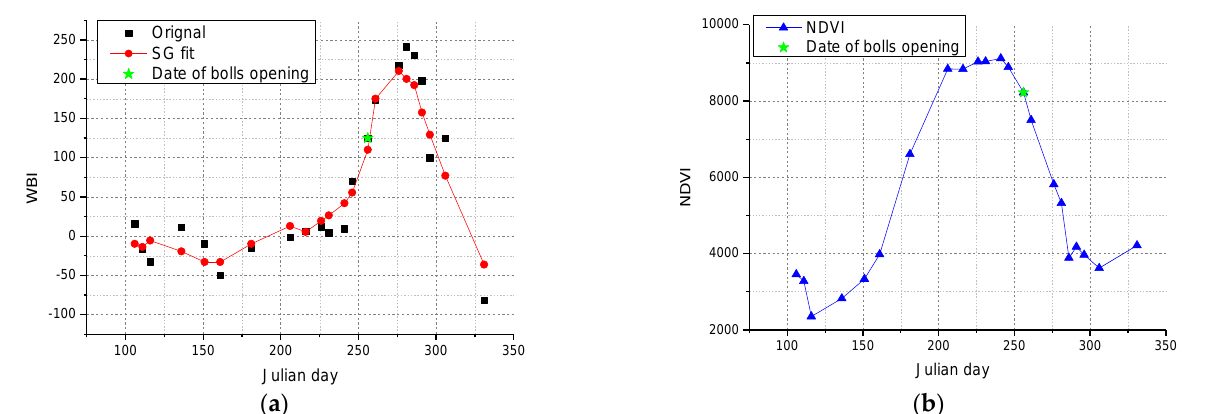
Figure 11. ( a ) The WBI time series, SG fit, and the midpoint extraction for bolls opening date. ( b ) The NDVI time series and the start date of bolls opening.